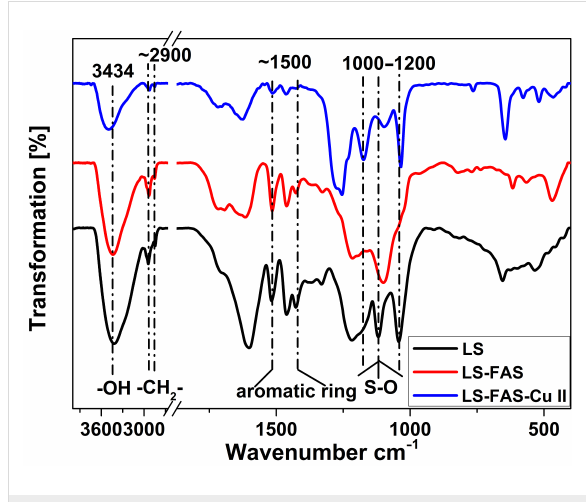
Figure 2: FTIR spectra of LS, LS-FAS, and LS-FAS-Cu.